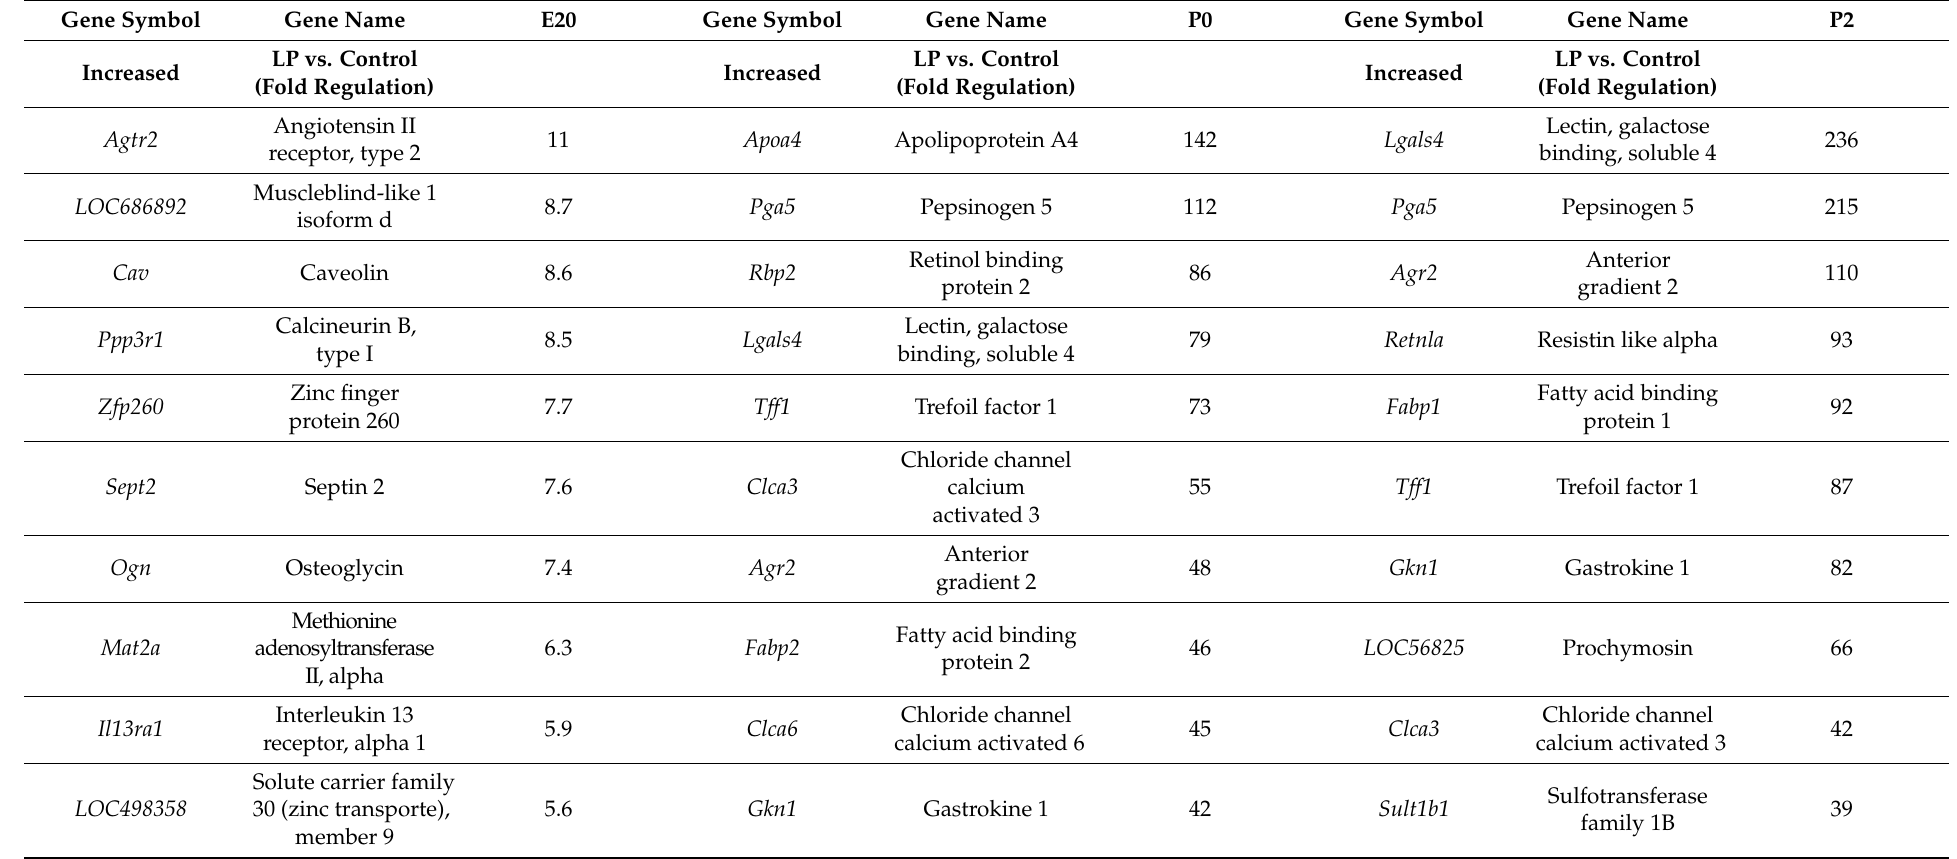
Table 2. Differential expression caused by the low-protein (LP) diet at E20, P0, and P2 in the 10 most up- or downregulated